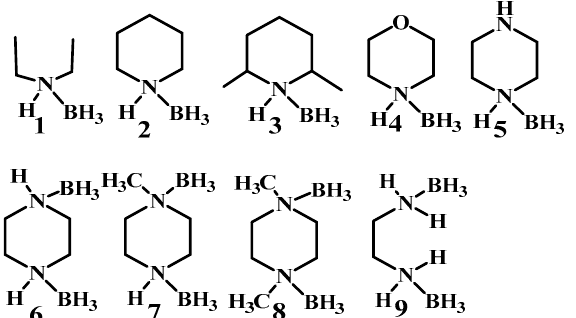
Figure 1. The structure of amine-boranes and diamine-bisboranes [13]. To improve the enthalpy of the formation ( ∆ H f ) and combustion ( ∆ H c ) of such AB based materials, a series of N -alkyl imidazole borane or cyanoborane complexes have been azole, the N -alkyl imidazole borane or cyanoborane complex obtained values of ∆ H f